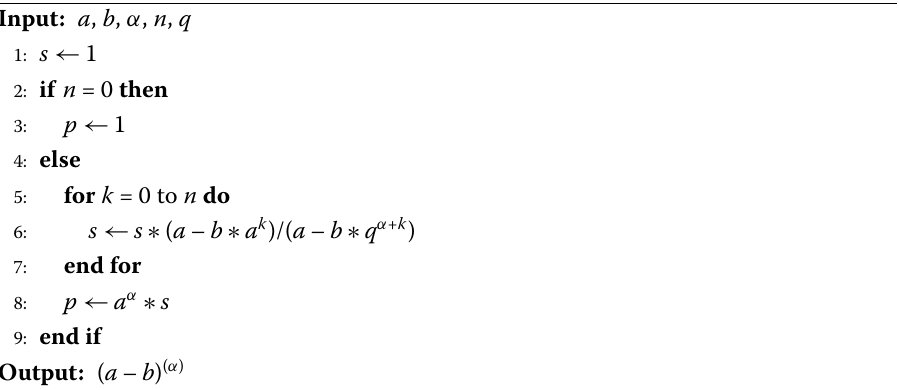
Algorithm 1 The proposed method for calculated ( a – b ) ( α )